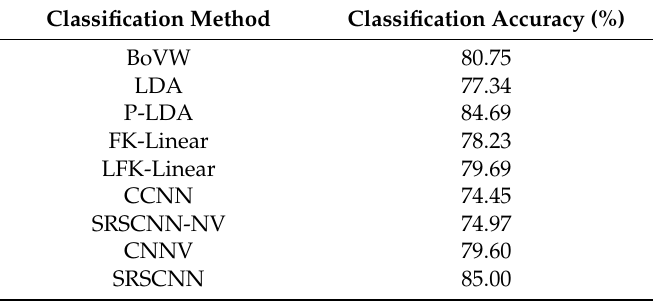
Table 5. Comparison between the previous reported accuracies with the Wuhan IKONOS dataset.